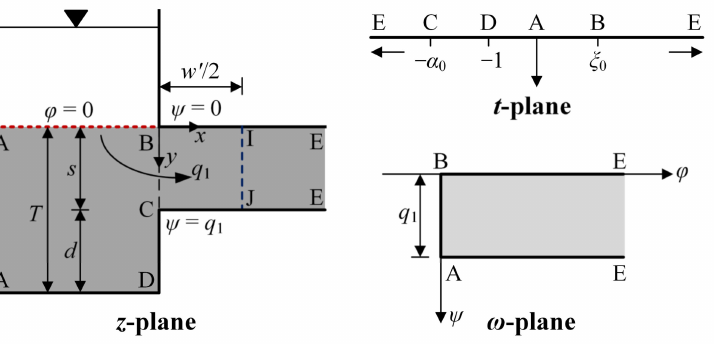
Figure 4. SCT mapping from the z -plane and ω -plane to the t -plane for the model in Figure